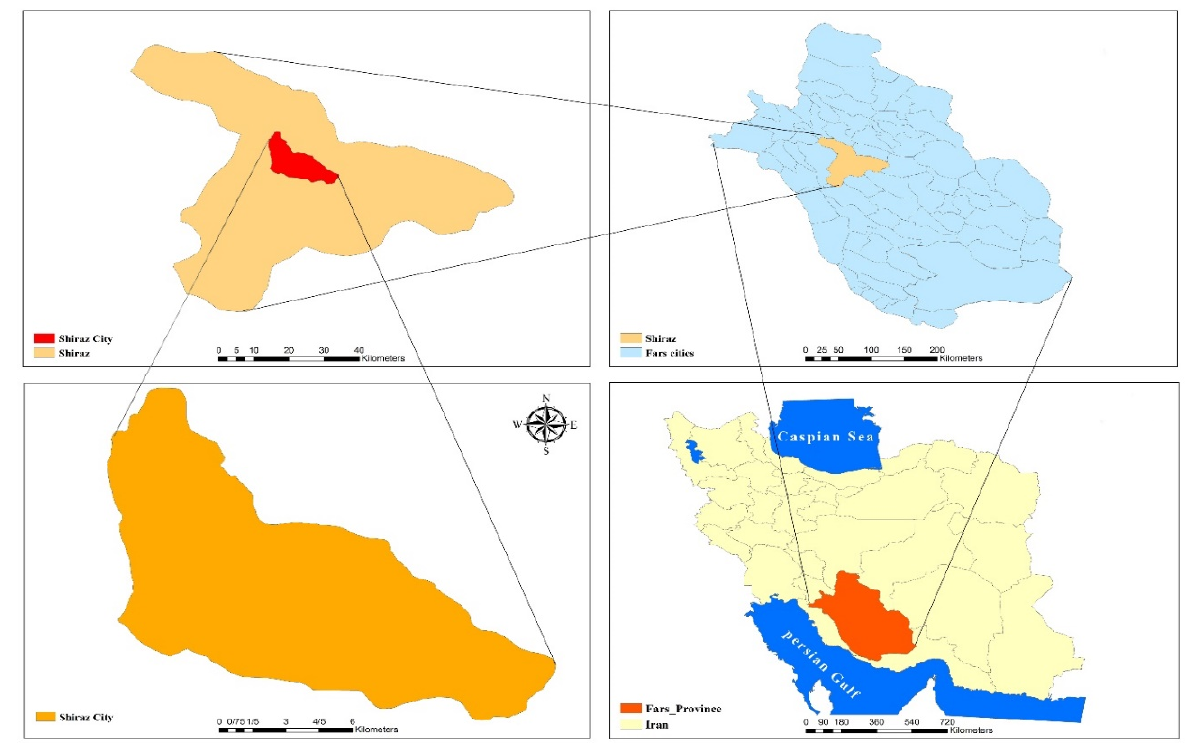
Figure 1. The general view of the location of Shiraz city and the studied region.